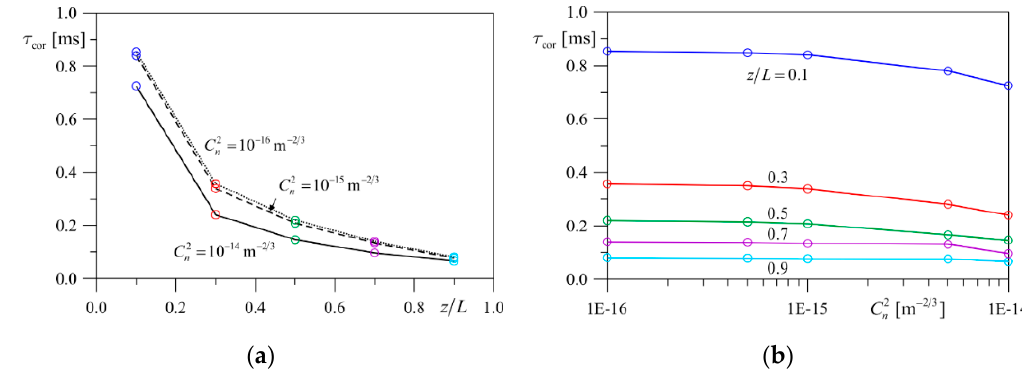
Figure 4. ( a ) Dependencies of the correlation time τ cor on the relative position z / L of a single turbulence layer of different turbulence strengths, C 2 n = 10 − 14 m − 2/3 (solid line), 10 − 15 m − 2/3 (dashed line), and 10 − 16 m − 2/3 (dotted line). ( b ) Dependencies of the correlation time τ cor on C 2 n for di ff erent relative positions of the layer, z / L = 0.1, 0.3, 0.5, 0.7, and 0.9, denoted by blue, red, green, purple, and sky-blue lines, respectively. Other parameters are the same as in Figure 3.